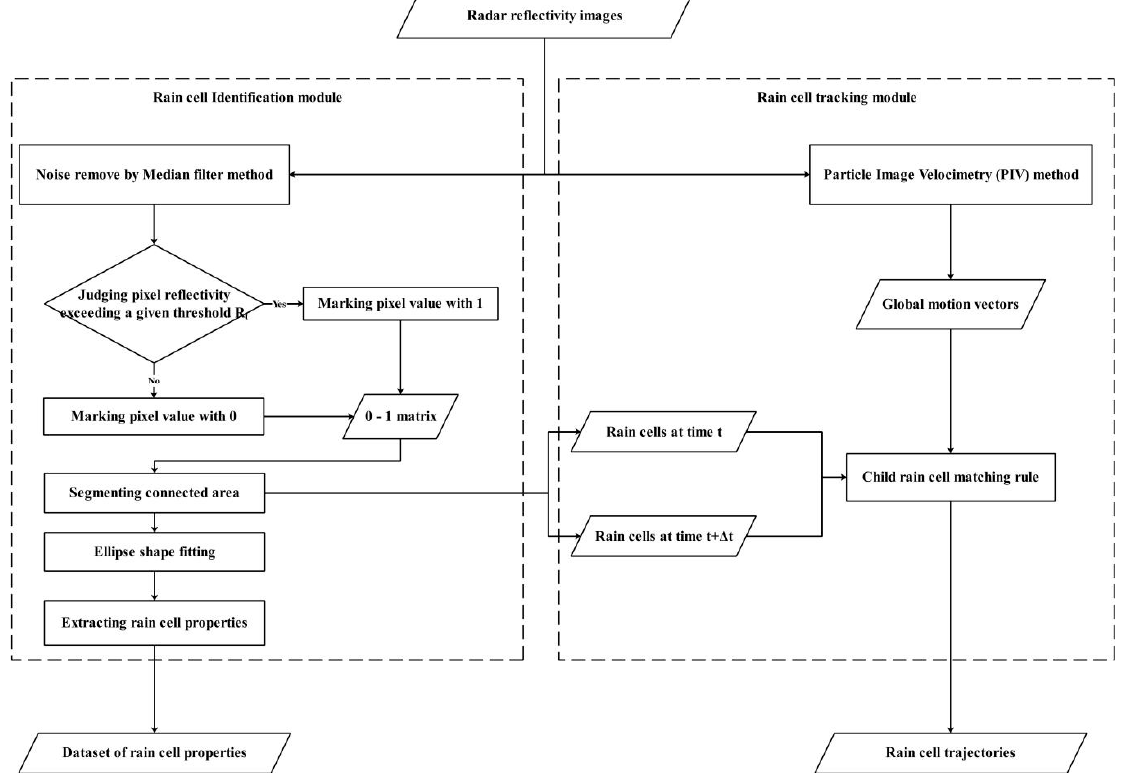
Figure 1. Step illustration of RCIT algorithm.